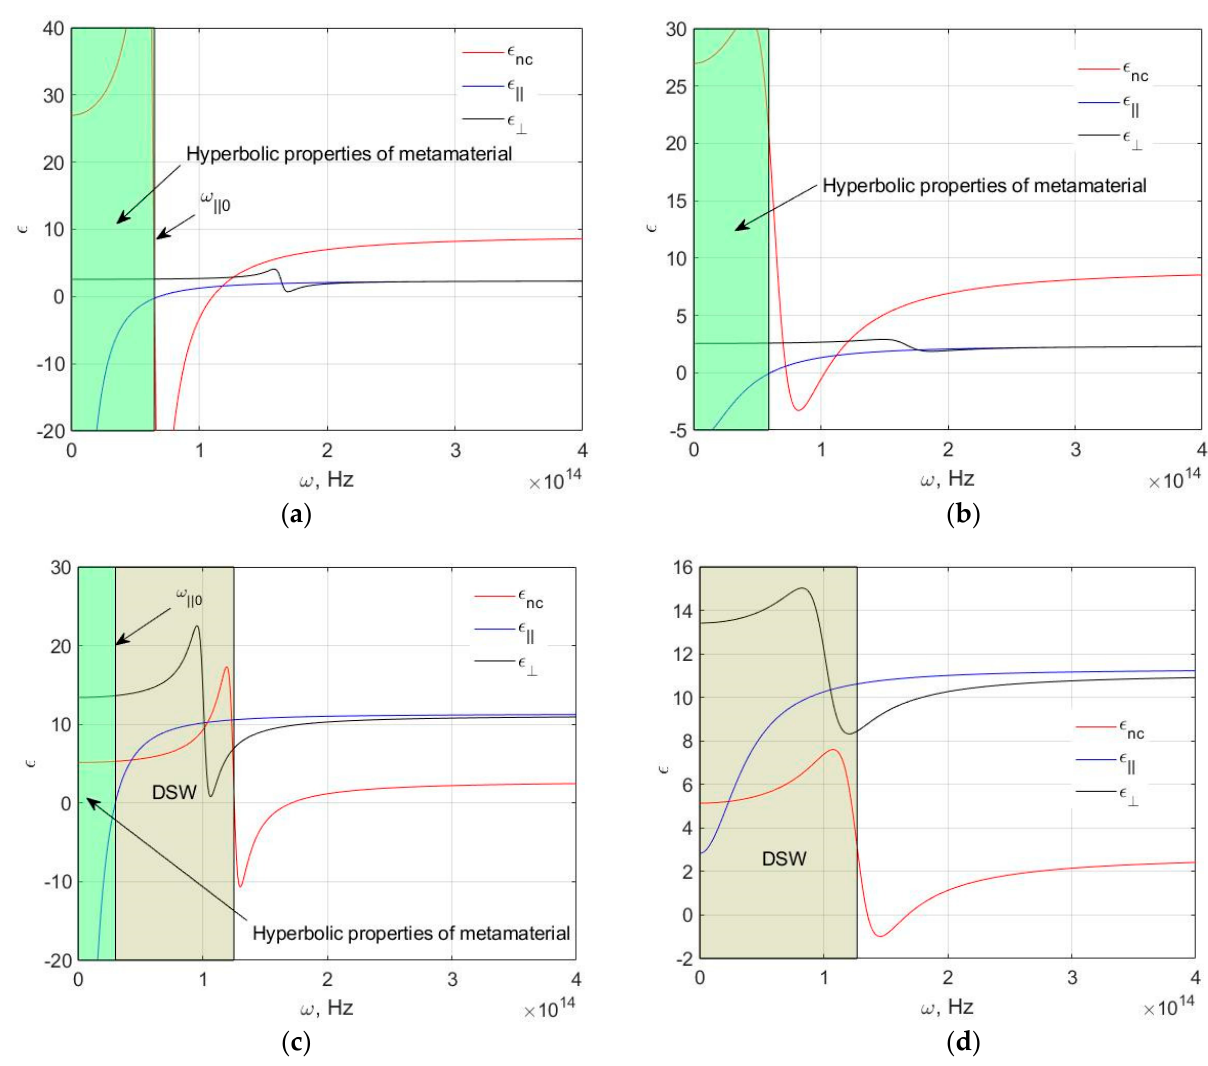
Figure 2. Relative permittivity components of the nanocomposite and hypercrystal versus frequency. Herein, f = 0.3. ( a , b ) ε n = 11.8, ε d = 2.25; ( c , d ) ε n = 2.25, ε d = 11.8. Herein AZO ( a , c ) and ITO ( b , d ) inclusions are employed in nanocomposite and